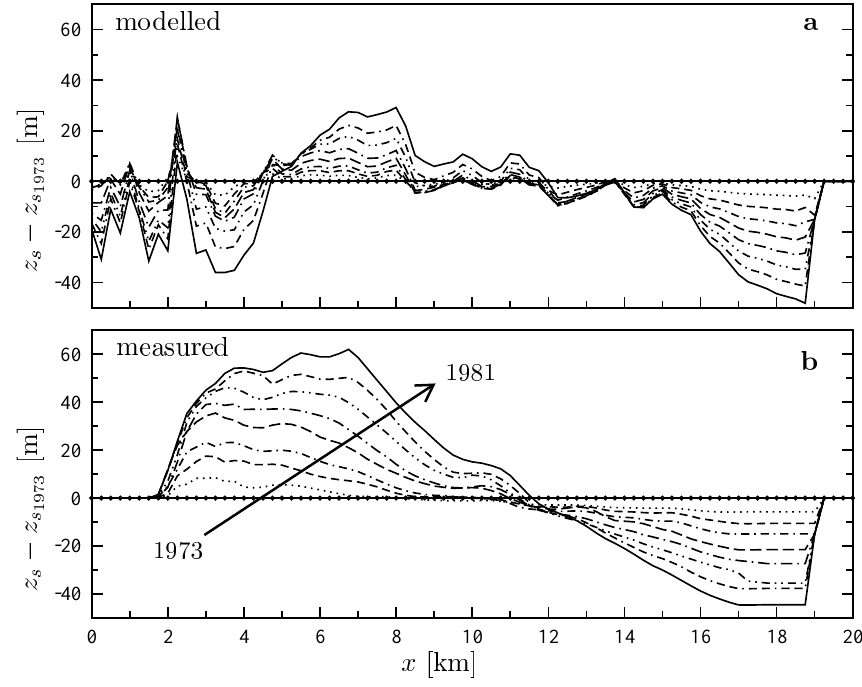
Fig. 9. Comparison of (a) modelled and (b) measured surface geometries relative to the 1973 surface topography for each date during the quiescent phase.